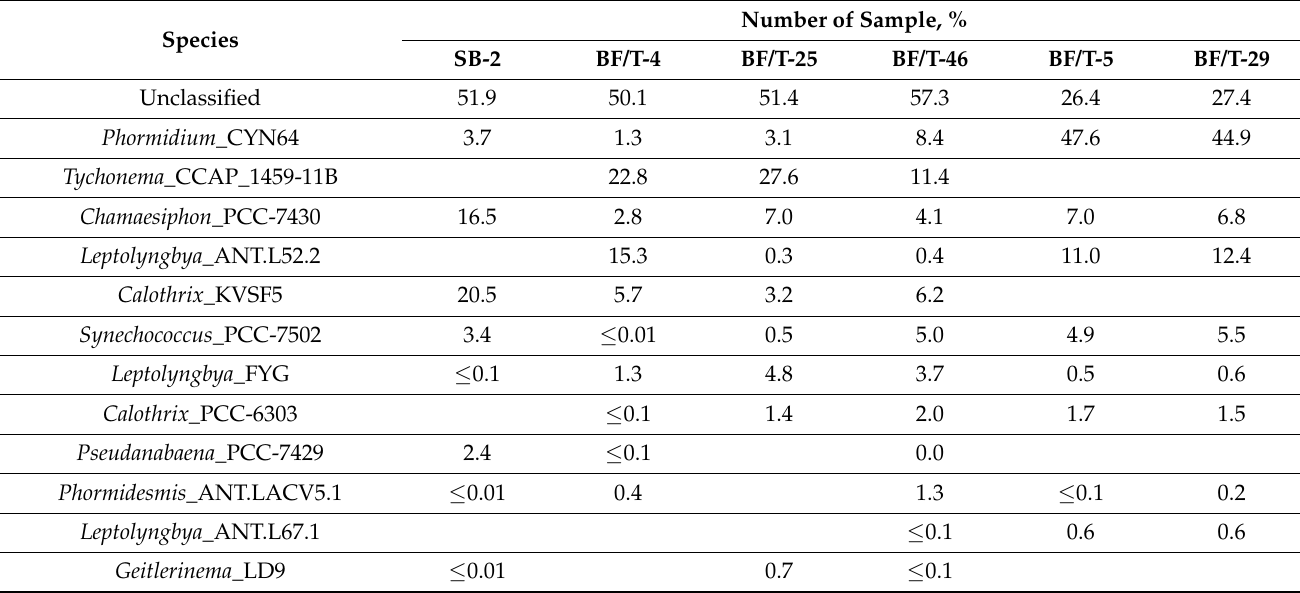
Table 3. The list of cyanobacterial genera with participation in microbiome of studied